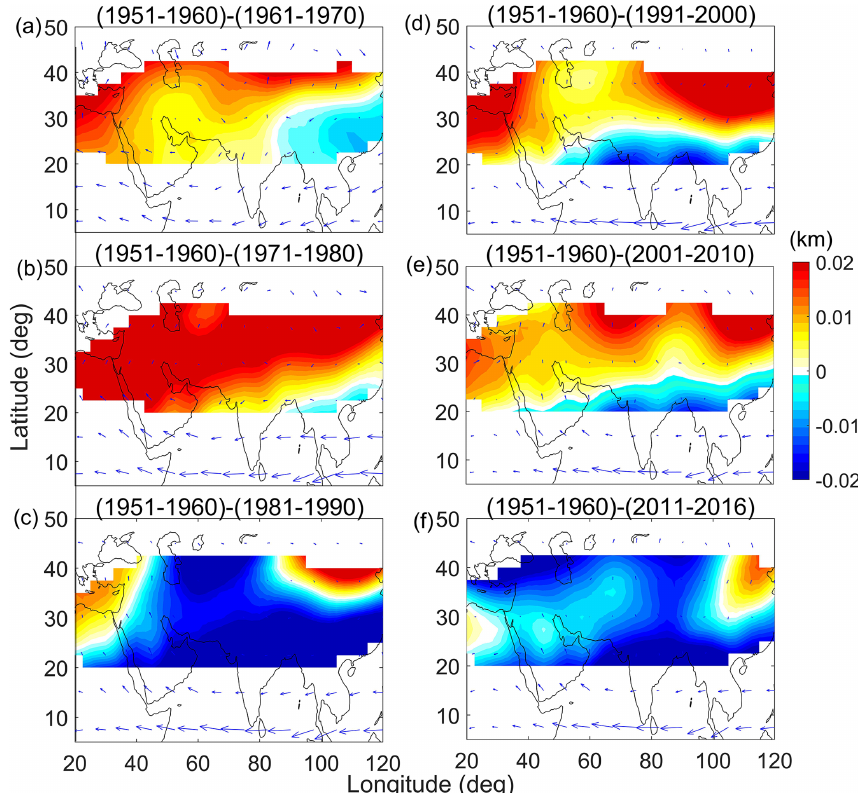
Figure 2. Decadal variation of the anticyclone obtained from the GPH and wind vectors with reference to the 1951–1960 period.